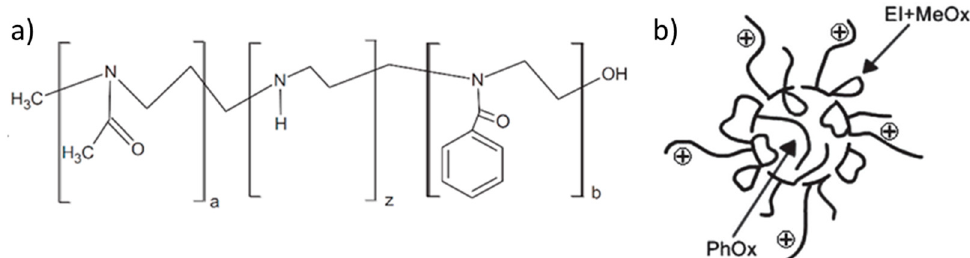
Figure 5. Chemical structure of poly(2-methyl-2-oxazoline)-polyethyleneimine-poly(2-phenyl-2-oxazoline) (PMeOx–PEI–PPhOx) gradient copolymers ( a ) and schematic representation of the formed aggregates ( b ). Adapted from Vlassi et al. as published by the Wiley-VCH Verlag GmbH [45].